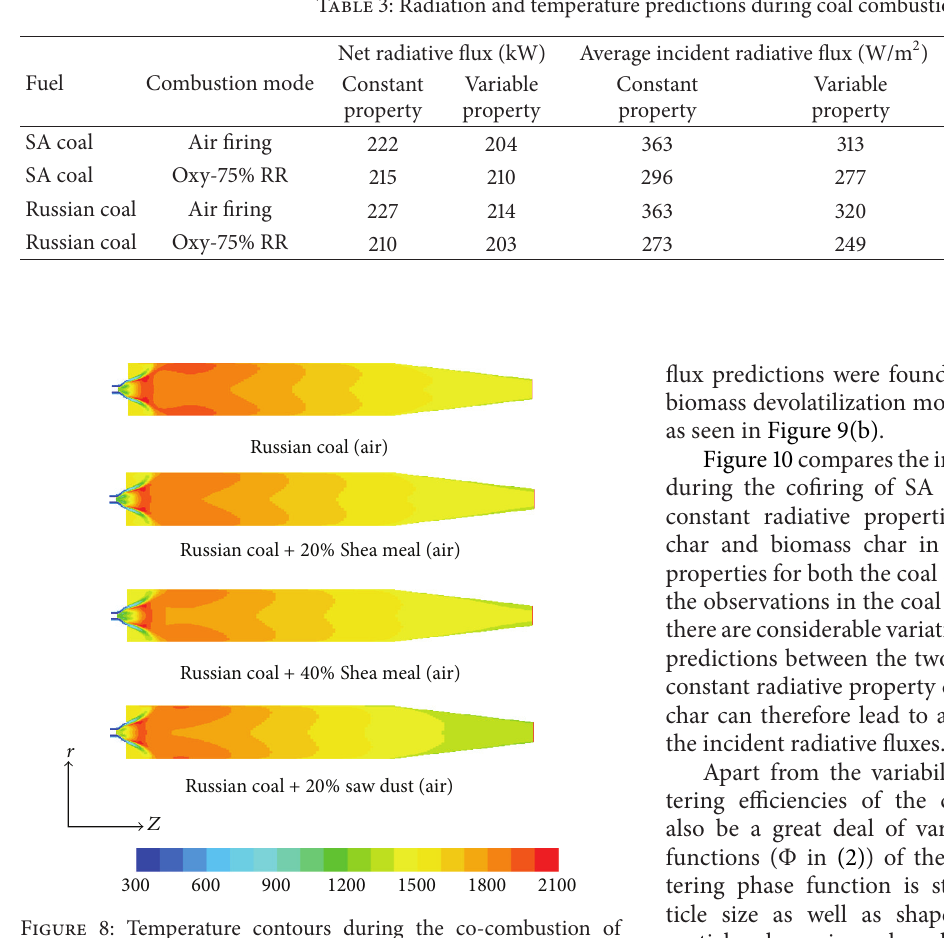
Figure 8: Temperature contours during the co-combustion of Russian coal and biomass particles in